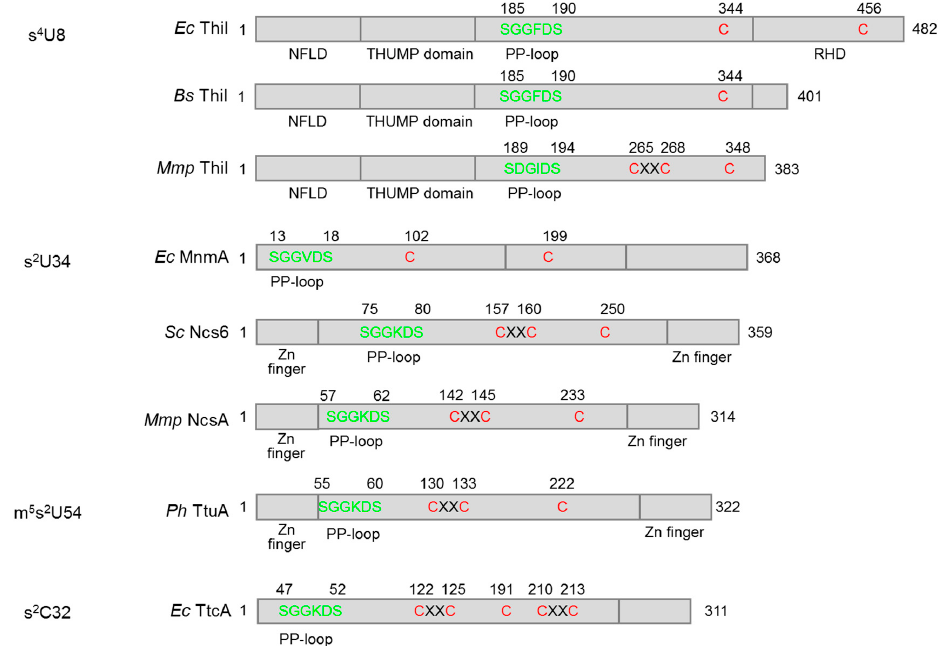
Figure 2. Domain structures of the s 4 U8 synthetase (ThiI), s 2 U34 synthetase (MnmA, Ncs6, or NcsA), m 5 s 2 U54 synthetase (TtuA), and s 2 C32 synthetase (TtcA). The PP-loop (ATP-binding) motif and putative catalytic site Cys residues are colored in green and red, respectively. The domain structures of ThiI, MnmA, and Ncs6 are based on the solved crystal structures of Bacillus anthracis ThiI, E. coli MnmA, and Pyrococcus horikoshii TtuA, respectively. Abbreviations: Ec , E. coli ; Bs , Bacillus subtilis ; Mmp , Methanococcus maripaludis ; Sc , Saccharomyces cerevisiae ; Ph , Pyrococcus horikoshii ; NFLD, N-terminal ferredoxin-like domain; THUMP, thiouridine synthases, methylases and pseudouridine synthases; RHD, rhodanese homology